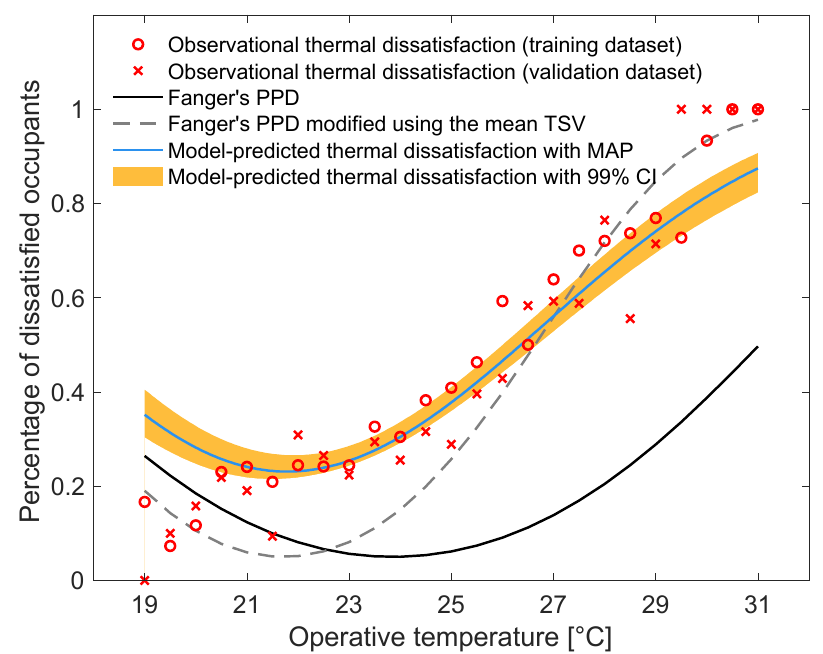
Figure 5. Relationship between the operative temperature and the percentage of dissatisfied occupants.